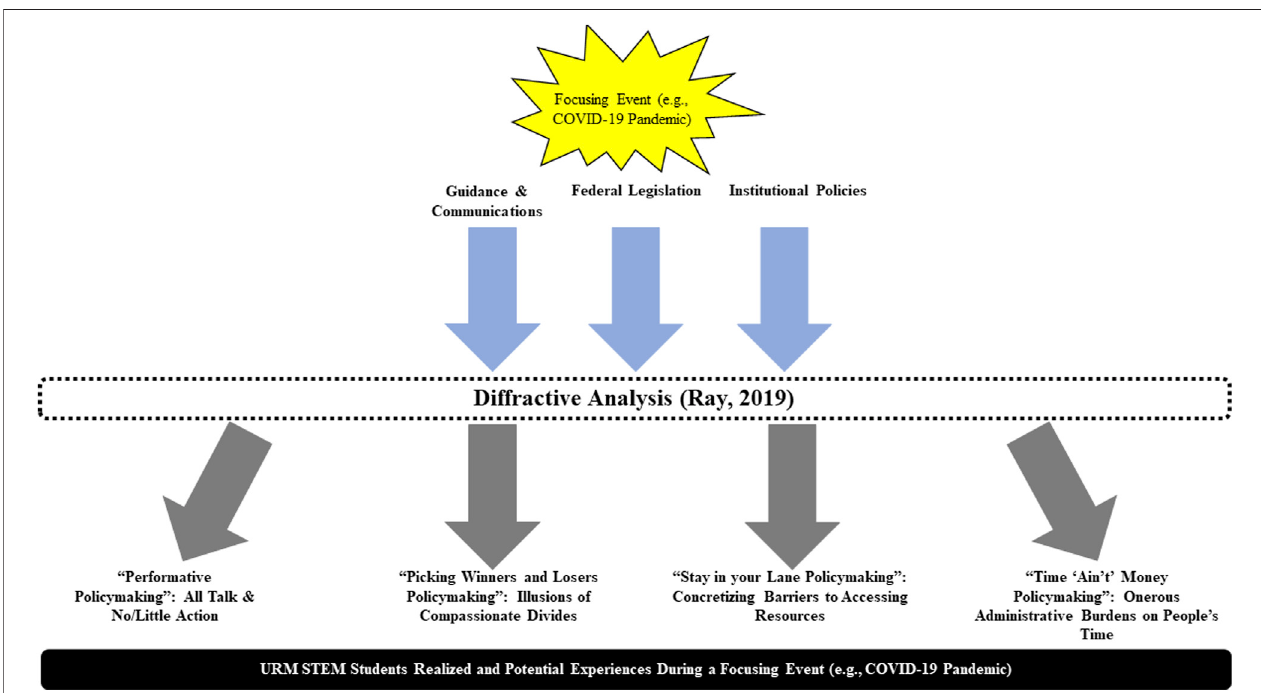
FIGURE 1 | Diagram of a Diffractive Reading of COVID-19 Policies and Communication Impact on URM STEM Students.